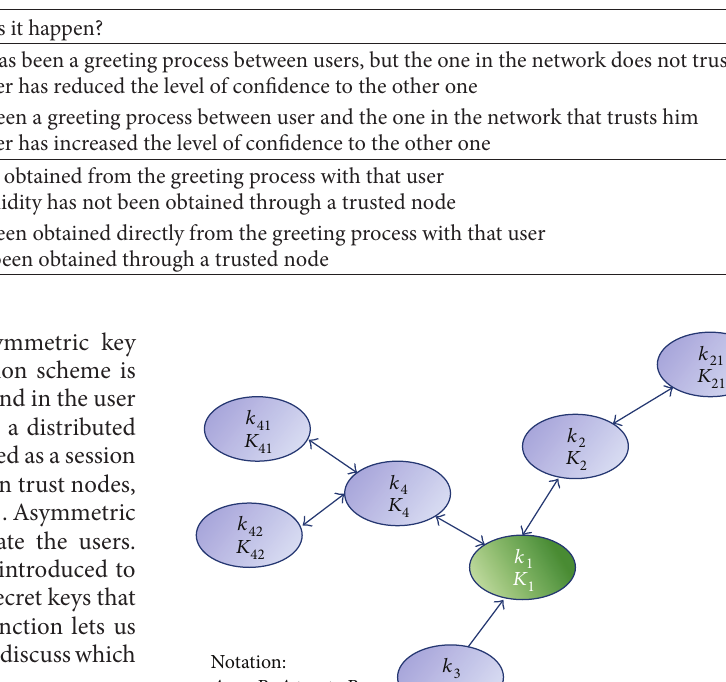
Table 1: Trust and validity values.